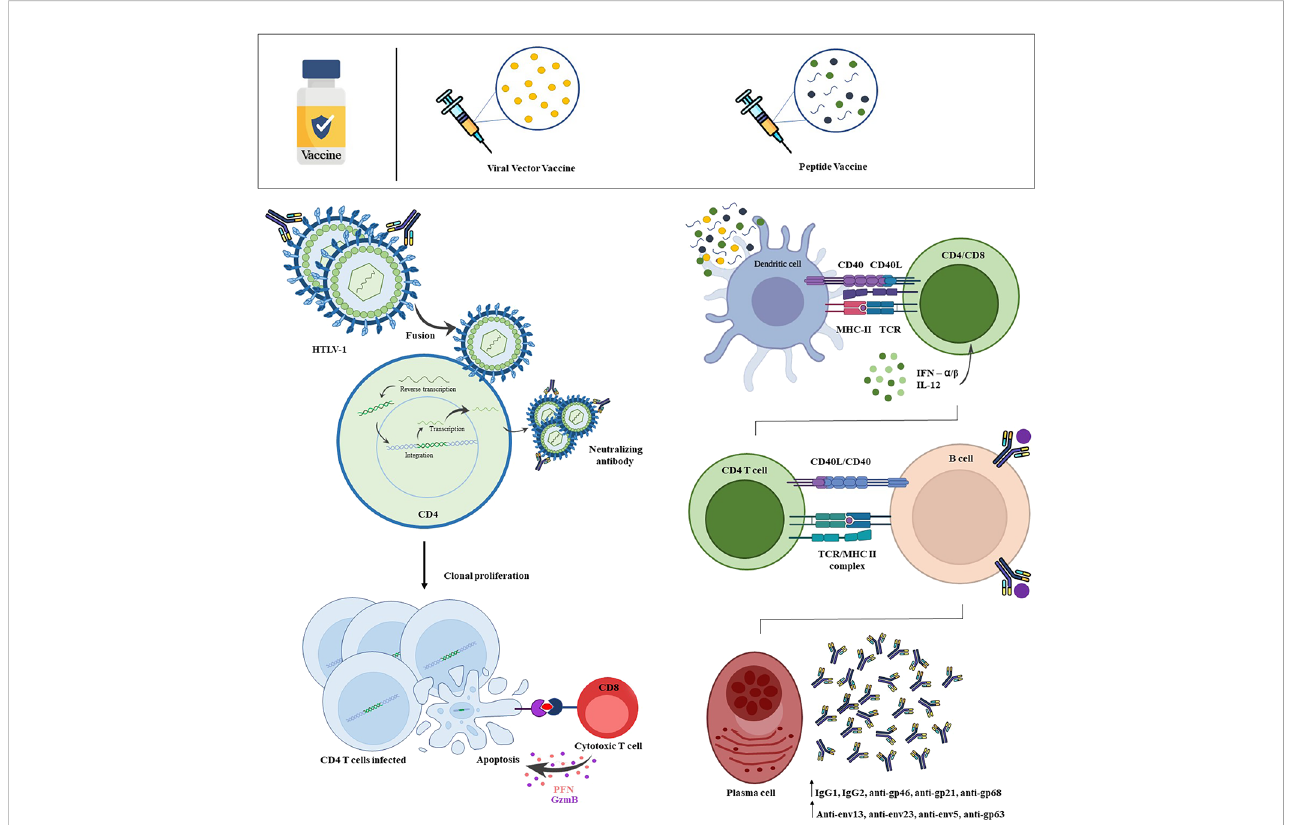
FIGURE 2 Scheme of HTLV-1 infection and vaccine-induced immune response. HTLV-1 ef fi ciently infects T-lymphocytes, with a priority tropism for CD4+ T- lymphocytes. By infecting the host cell, viral proteins play a crucial role in the process of integrating the proviral genome into the host genome. From this, these infected cells show changes in cell behavior, inducing an intense and persistent activation, clonal expansion and cell immortalization. The vaccine-induced immune response begins from the recognition of viral antigens by dendritic cells, which will capture and present through the Class I MHC and Class II MHC complex to naives CD8+ T-lymphocytes and CD4+ T-lymphocytes, respectively. Viral antigens will also be recognized by naive B-lymphocytes, which will become activated and may present antigen to CD4+ T-lymphocyte, inducing the formation of antibody-producing plasmocytes with high af fi nity and memory B-cells. Thus, HTLV-1 is neutralized before binding with the host cell by vaccine-induced neutralizing antibodies, more strongly veri fi ed by the protein subunit vaccine. The viral vector vaccine was able to induce the production of cytotoxic CD8+ T- lymphocytes, that cause apoptosis of HTLV-1 infected CD4+ T-cells by release of granzyme and perforin. Created with Microsoft PowerPoint and Adobe